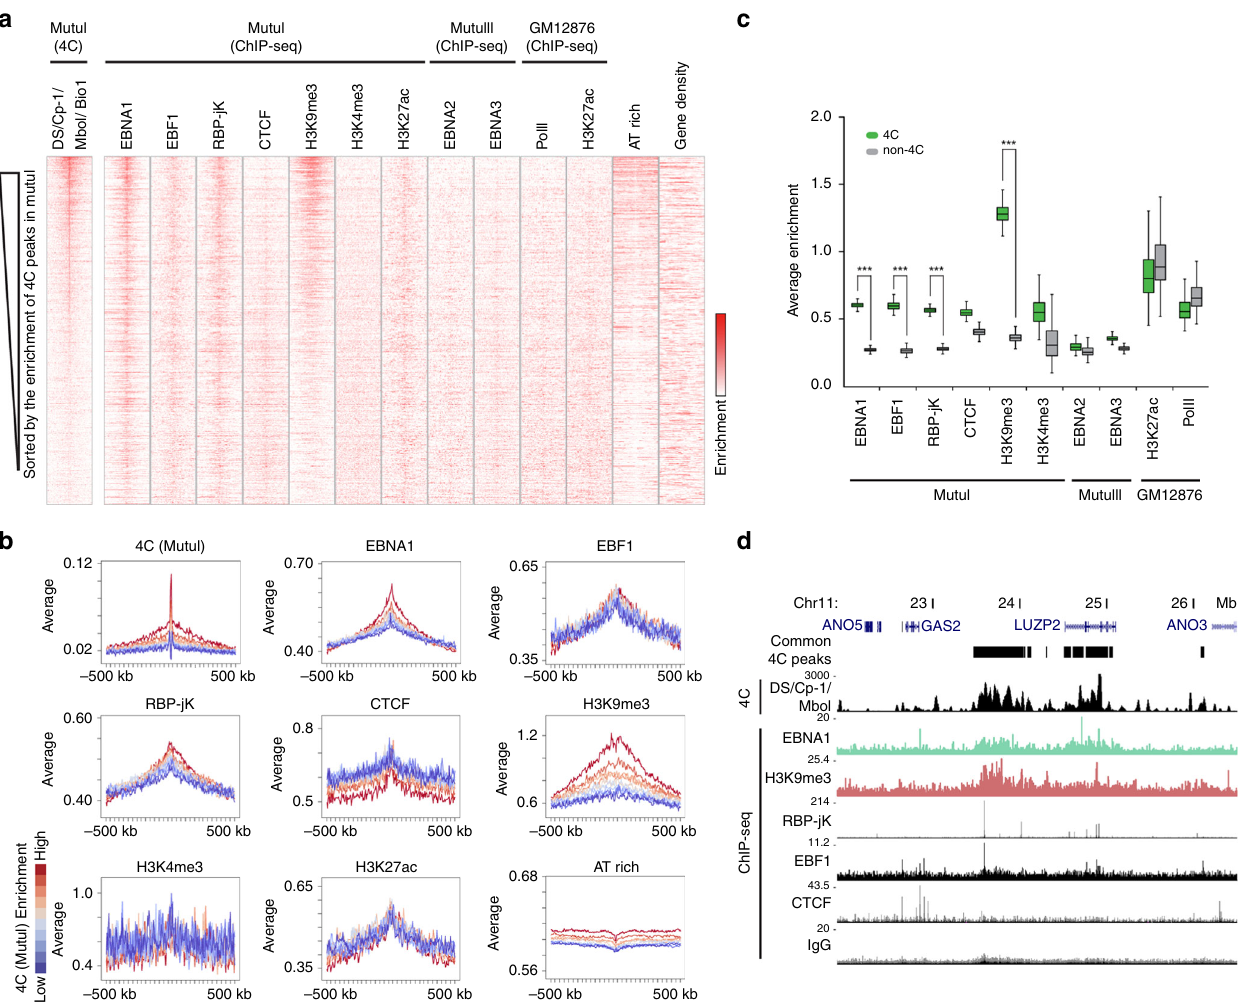
Fig. 3 Epigenetic signature of EBV tethering sites. a Heatmap comparison of 4C (MutuI cell, DS/Cp-1 bait, MboI restriction site) with other ChIP-seq data, AT rich sequence and gene density (5 kb bin, 500 kb range). ChIP-seq scores were converted to log values. Red color corresponds to maximum score. White color corresponds to average score. b Average sequence enrichment for the indicated ChIP-seq proteins and AT rich sequence classi fi ed into 10 groups based on the 4C (MutuI) scores (top: red → bottom: blue). c Box plot quantitation of ChIP-seq intensity overlapping 4C peaks or non-4C peaks. Boxplots show center quartiles, midlines show medians and whiskers extend to the data points, which are no more than 1.5× the interquartile range from the box. Error bar represents the standard deviation and P -value were calculated by two-sided Mann – Whitney U test. d UCSC genome browser image showing the comparison of 4C with other ChIP-seq data along the indicated